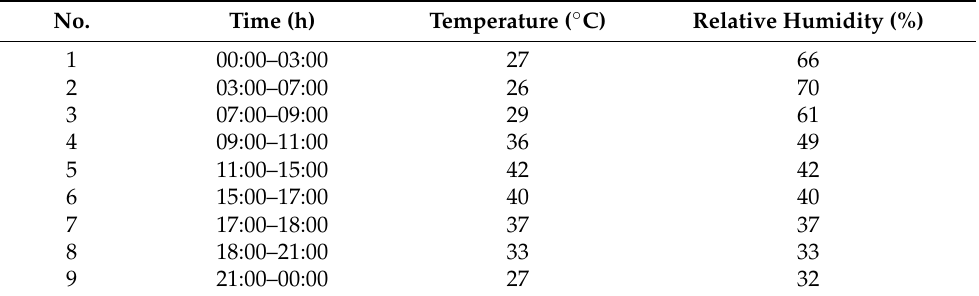
Table 4. Temperature control data and relative humidity in the growth chamber (VRV.Corp., Ltd., Bangkok, Thailand).